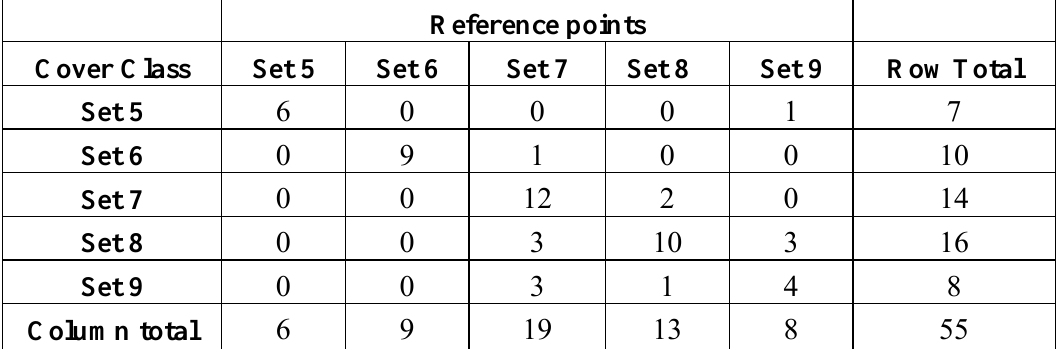
Table 2B. Another sample of classification error matrix of the uncorrected image (image 2, Milwaukee urban areas).